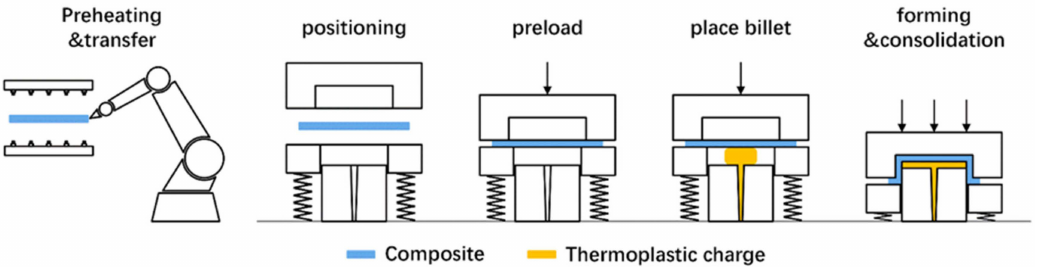
Figure 1. Concept of the one-step compression-stamping